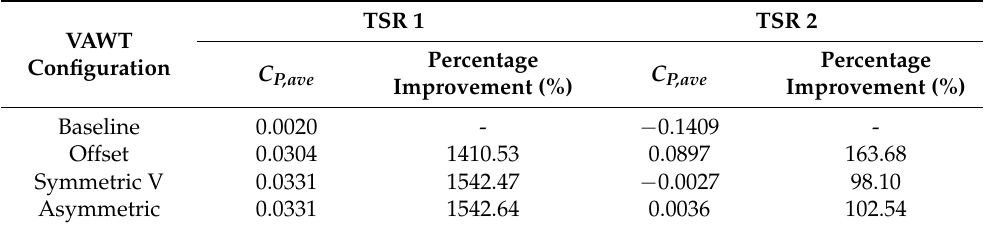
Figure 11. Pressure distribution on the suction surface of ( a ) baseline; ( b ) offset; ( c ) symmetry V endplate at θ = 120°. Table 4. Cycle-averaged C P at 0.015625H in TSRs 1 and 2.